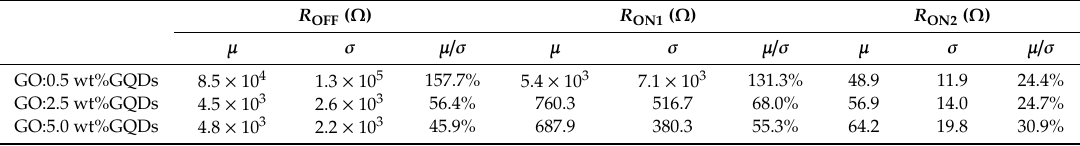
Table 3. Values μ and σ of the SET1, SET2 and RESET voltages ( V SET1 , V SET2 , and V RESET ) based on ternary memory performance.